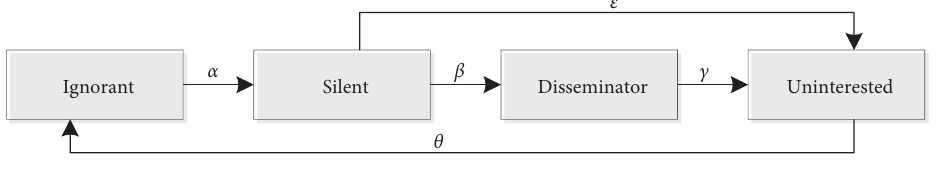
Figure 3: Information dissemination process of NIMBY